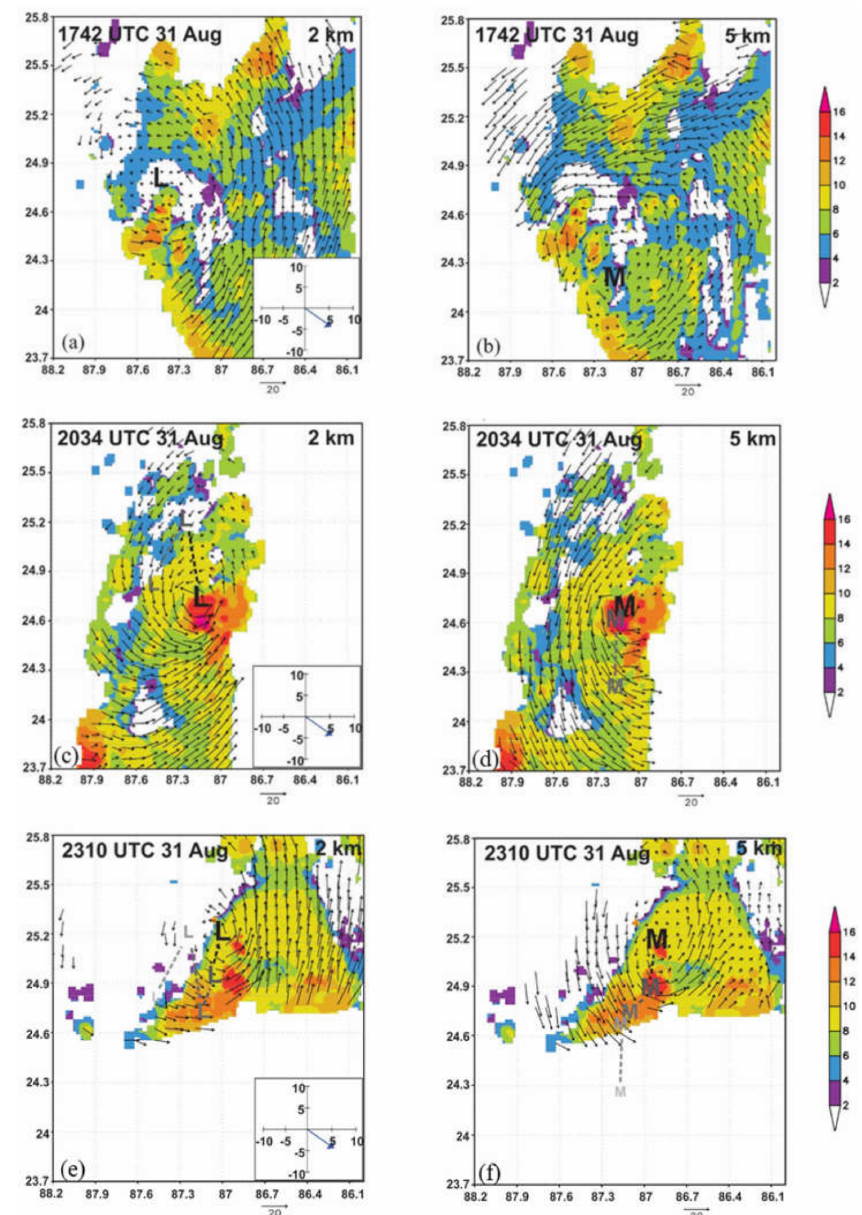
Figure 18. ( a ) Plot of 20 dBZ echo top heights (shaded, km) and storm-relative winds (vectors, m s − 1 ) at 2-km altitude forindividual center passes centered at 1742 UTC August 31 in Tropical Depression #9 (future Hermine); ( b ) As in ( a ), but for winds at 5-km altitude; ( c ) As in ( a ), but for 2034 UTC August 31; ( d ) As in ( b ), but for 2034UTC August 31; ( e ) As in ( a ), but for 2310 UTC August 31; ( f ) As in ( b ), but for 2310 UTC August 31. “L”and “M” denote locations of subjectively-determined circulation centers at 2- and 5-km altitudes, respectively. Lighter, smaller letters denote locations from previous center passes. Inset in lower right corner in ( a , c , e ) denotes SHIPS-derived 850–200 hPa shear. Adapted from